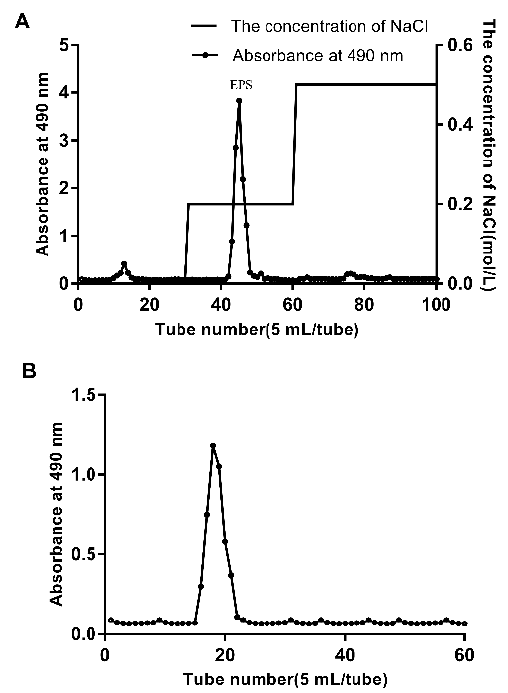
Figure 1. Purification of the crude EPS from Lpb. plantarum NMGL2 by anion-exchange chromatogra- phy on a DEAE-Sepharose Fast Flow column ( A ), and further gel permeation chromatography on a Sepharose CL-6B column ( B ).